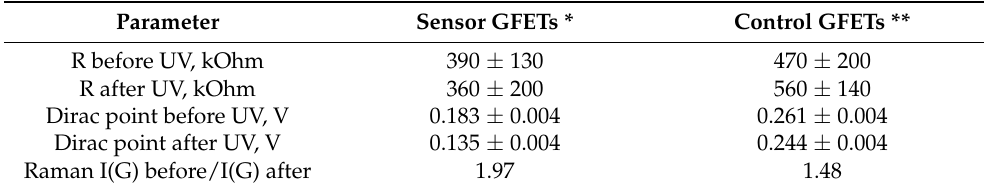
Table 1. The change in resistance (R), Dirac point, and G band intensities (I) after photochemical modification of graphene channel.